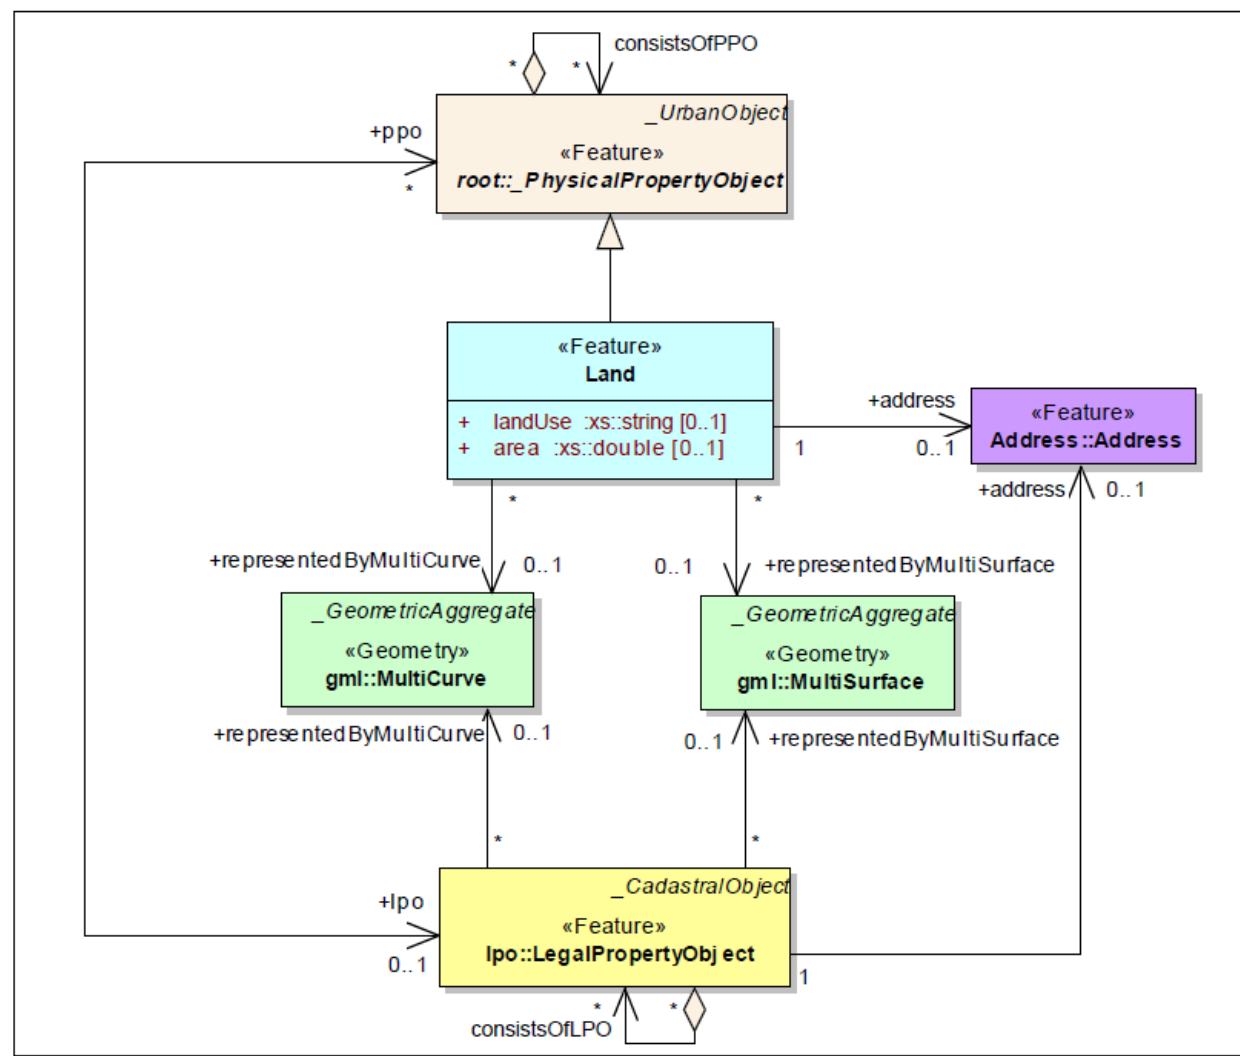
Figure 18. The UML diagram of 3DCDM Land